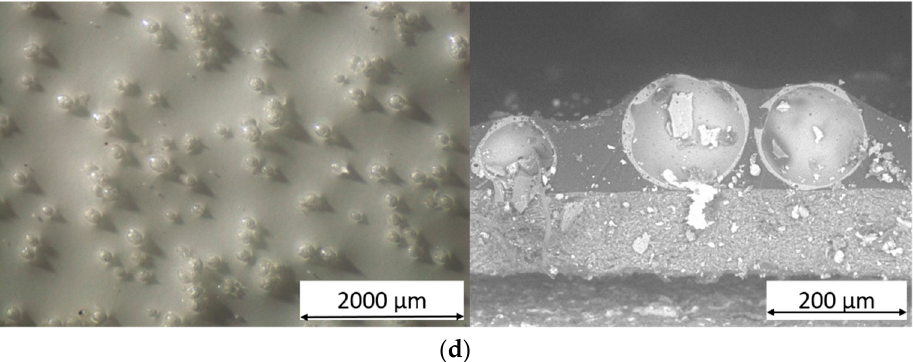
Figure 3. Optical microscope micrographs of the top-view (on the left) and SEM micrographs of the cross-section (on the right) of ( a ) sample G0, ( b ) sample G1, ( c ) sample G2 and ( d ) sample G3.